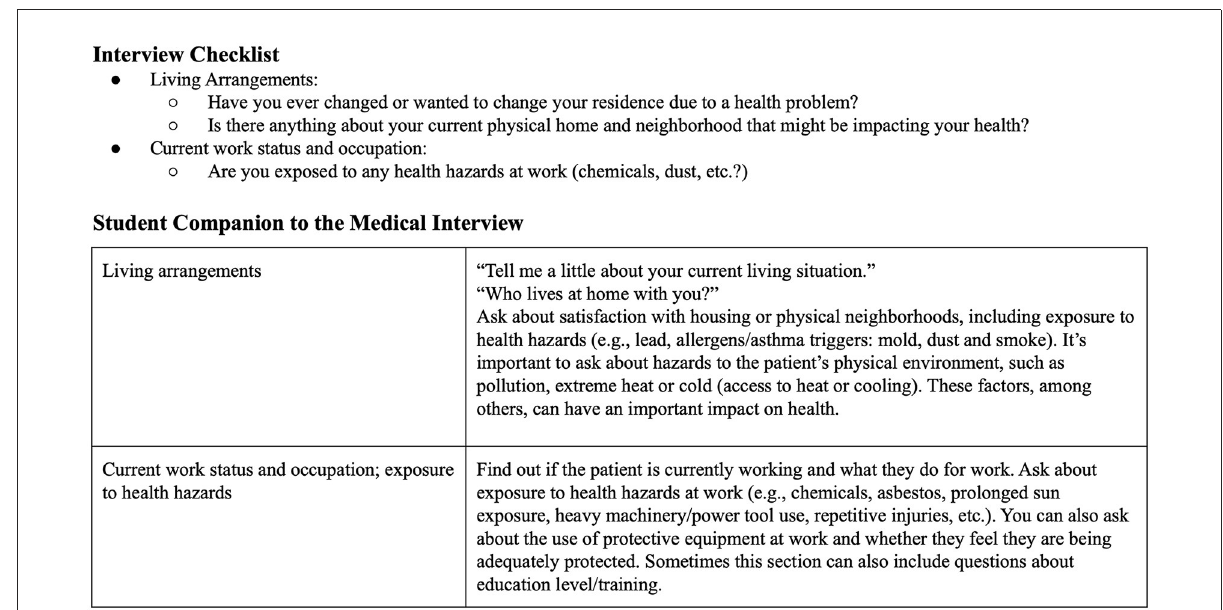
FIGURE2 Environmental exposure screening questions incorporated into the social history section of the patient interview checklist taught to first year medical students. Additional context was provided in the Student Companion to the Medical Interview, a medical interview guide available to all students.